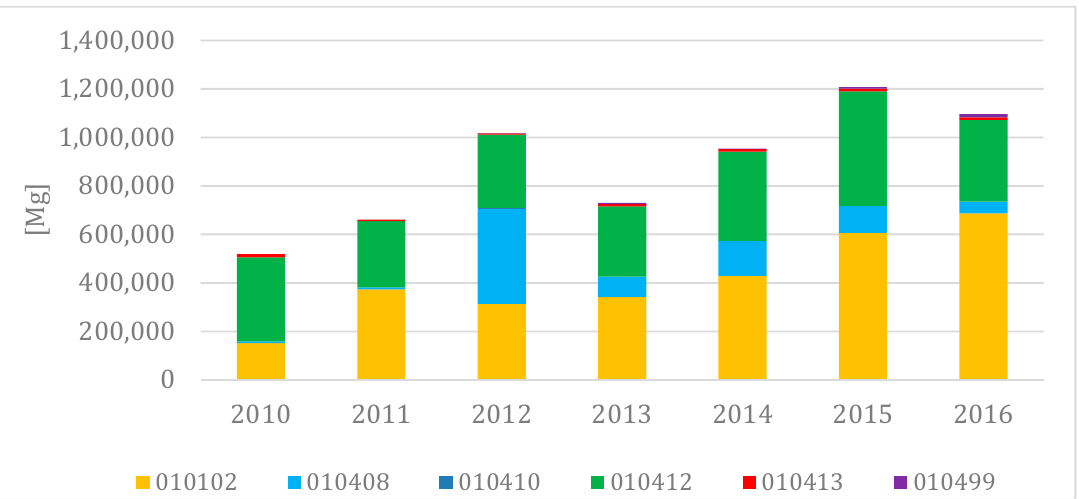
Figure 6. Mining waste types produced in rock mineral mining in the Lower Silesia Province in 2010–2016 [Mg]: 010102—mining waste; 010408—processing waste (gravels and crushed rocks); 010410—processing waste in the form of dusts and powders; 010412—waste generated during the flushing and cleaning of rock minerals; 010413—waste generated during cutting and processing of rocks; and 010499—other waste from the processing of rock minerals.